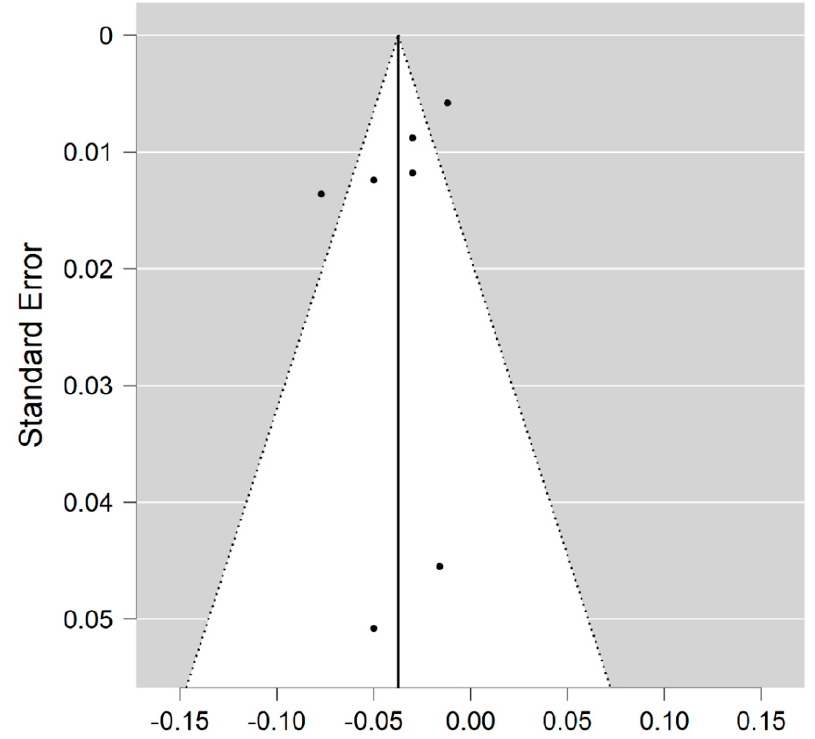
Figure 5. Funnel plot for the NDI in NAWM (MS vs. control).